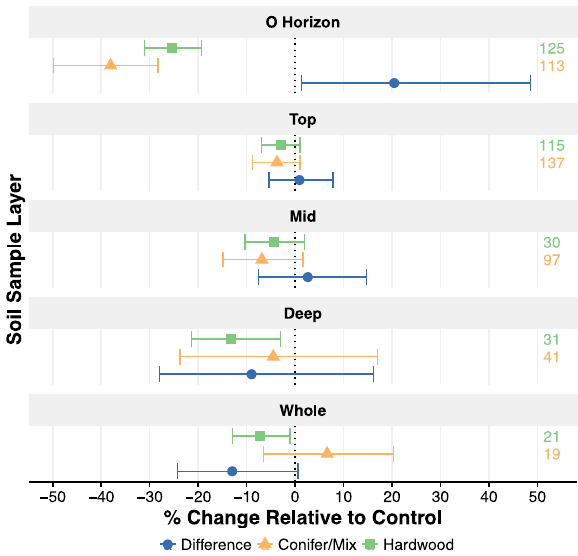
Figure 3. Response of soil C harvesting at different depths in soil, broken down by hardwood or conifer/mixed forest types. Mean effect sizes ± 95% confidence intervals calculated by nonparametric bootstrap are shown for hardwood and conifer/mixed forests. Blue circles show the mean difference between these forest types (Hardwood–Conifer/Mix) ± 95% confidence interval for the difference. Differences are calculated on the logarithmic effect size scale, and then back-transformed to % change, and thus do not necessarily add up on the % change scale. The number of response ratios ( k ) in each forest type at each depth is listed on the right. Data for very deep soil is not shown because there were no observations for this soil layer in hardwood forests.